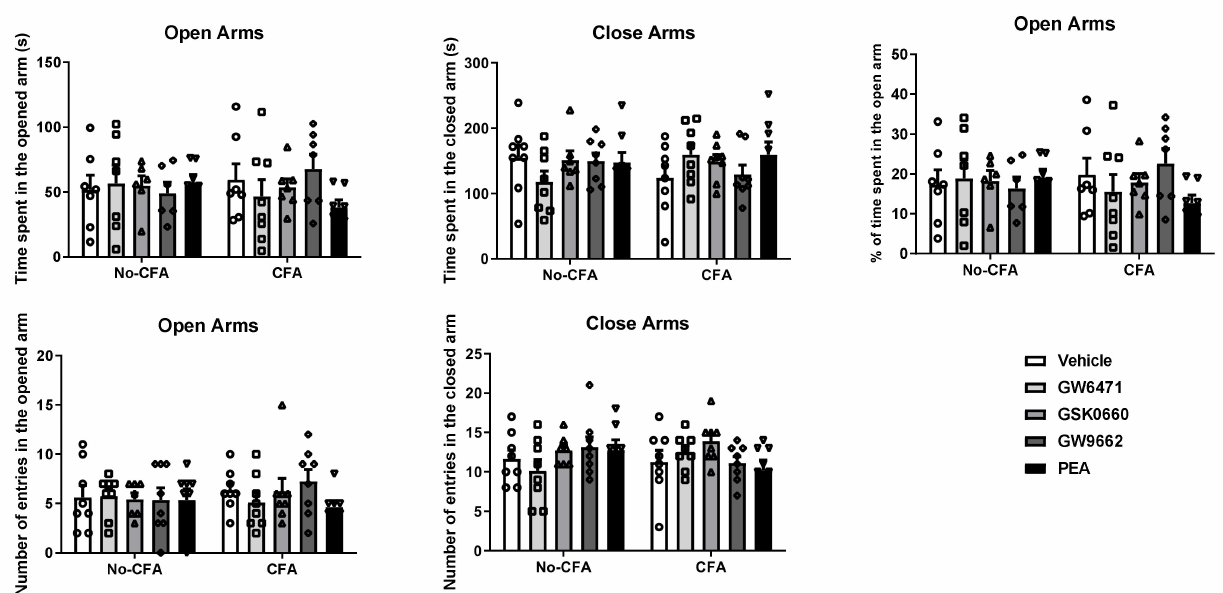
Figure 4. Effects of systemic administration of vehicle, selective PPAR α (GW6471), PPAR β / δ (GSK0660) and PPAR γ (GW9662) antagonists, and PEA on anxiety-related behaviours in the EPM test in CFA-injected (CFA) and control (No-CFA) rats. Data are expressed as means ± SEM ( n = 8 rats per group). The symbols represent each individual data point.